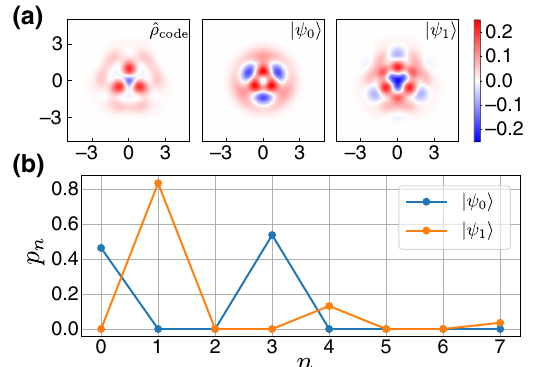
FIG. 6. (a),(b) Wigner functions and photon-number distribu- tions for another variant of the